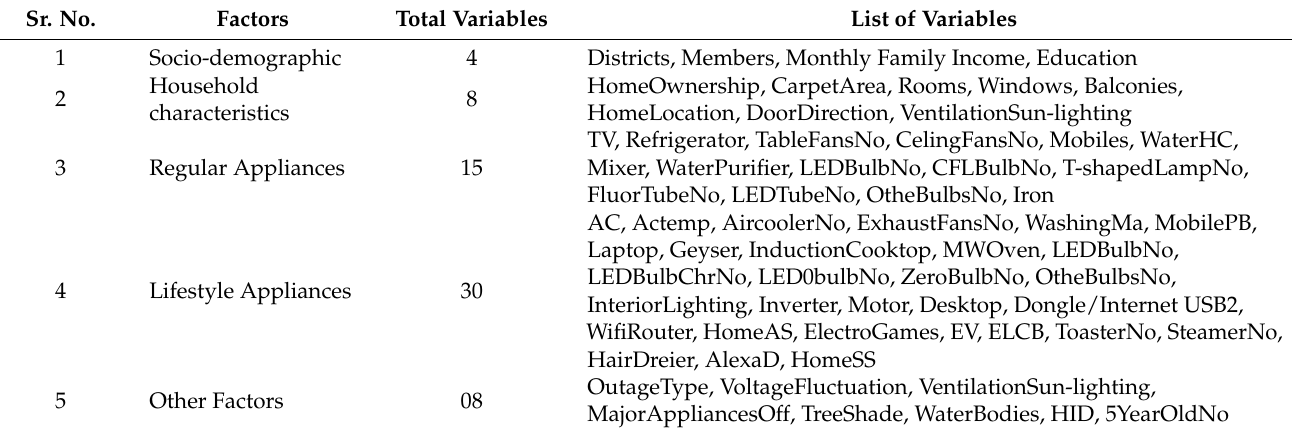
Table 3. List of QS factors and variables.